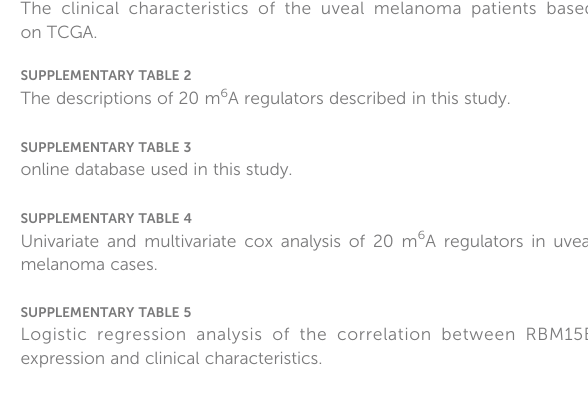
SUPPLEMENTARY FIGURE 2 Clinical characteristics of four groups from 80 UM patients based on TCGA database. SUPPLEMENTARY FIGURE 3 Location of RBM15B and the expression and protein level of RBM15B. SUPPLEMENTARY FIGURE 4 Alteration frequency of RBM15B and its in fl uence on prognostic